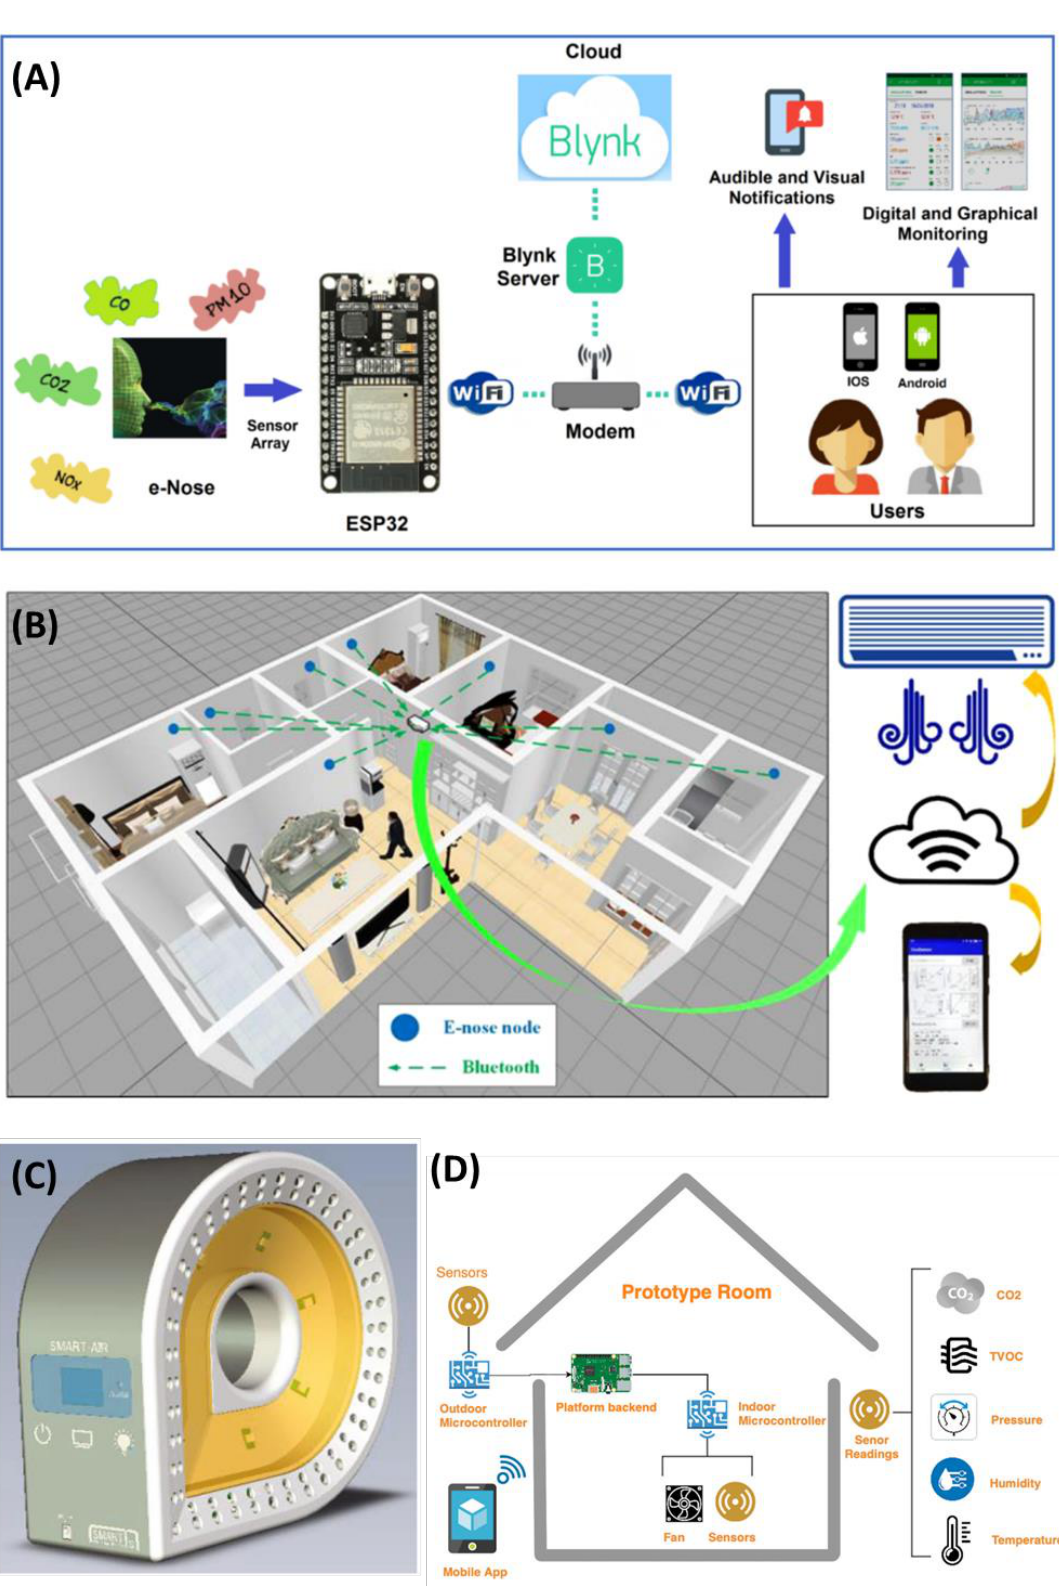
Figure 4. Illustration of the proposed electronics nose (E-nose) system architecture ( A ); the proposed E-nose application in future smart buildings ( B ); primitive concept design of Smart-Air ( C ); and a smart ventilation system for optimizing indoor air quality (IAQ) Levels in buildings ( D ). Reproduced with permission from